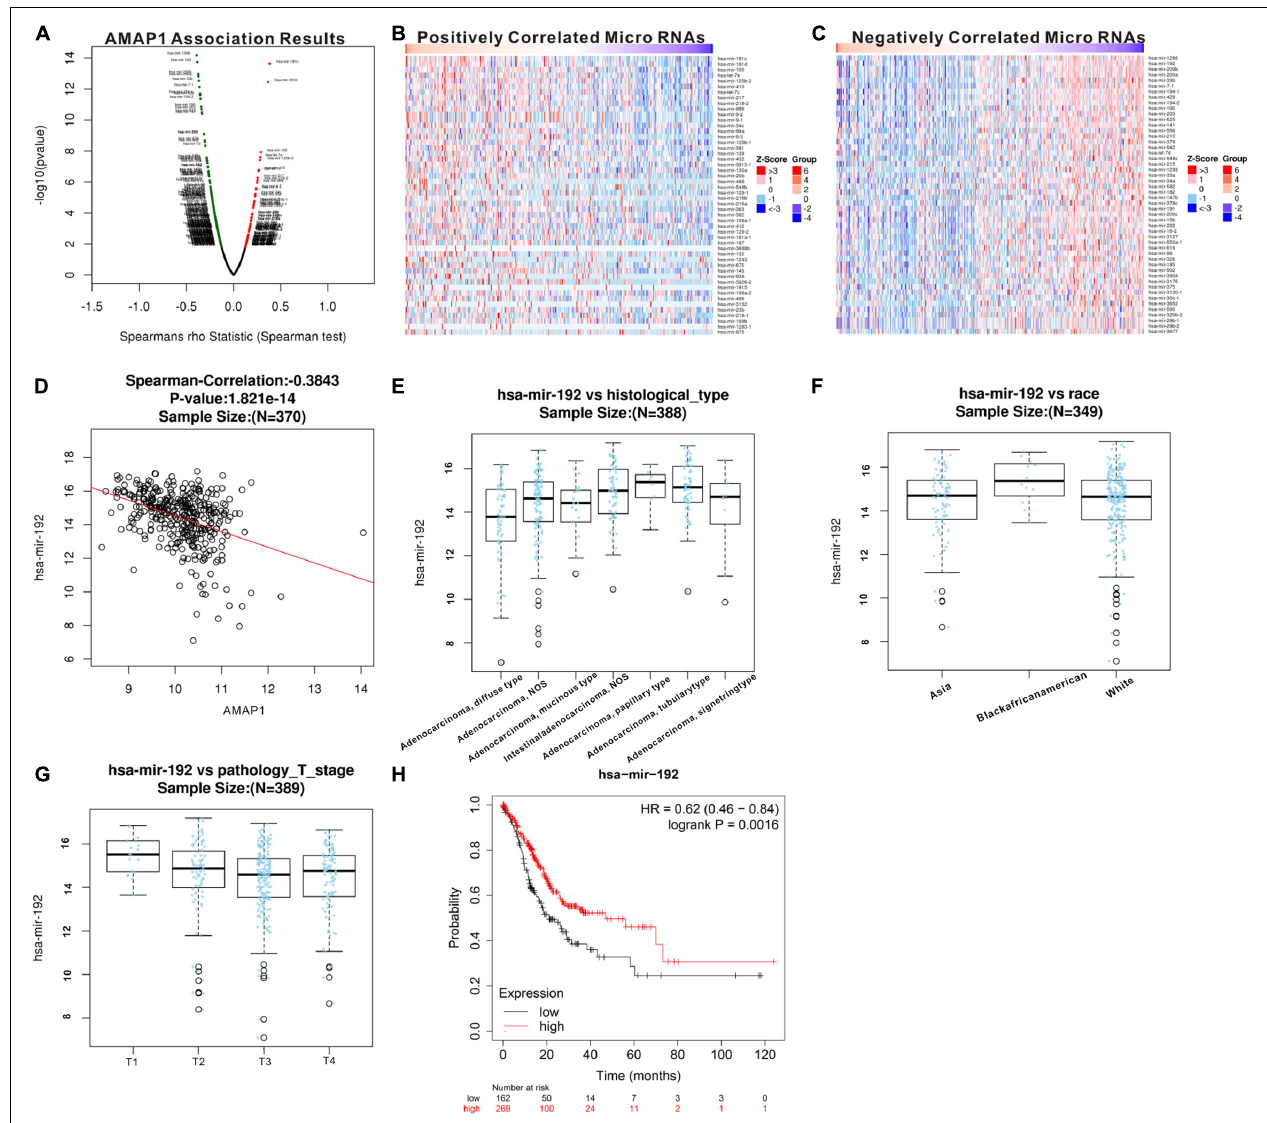
FIGURE 6 | Identification of MicroRNAs associated with AMAP1mRNA expression in 415 gastric cancer samples from the linkedomics database. Volcano plot of MicroRNAs significantly associated with AMAP1mRNA (A) . The top 50 MicroRNAs positively correlated to the expression of AMAP1mRNA (B) . The top 50 MicroRNAs negatively correlated to the expression of AMAP1mRNA (C) . Scatter plot of the association between AMAP1mRNA expression and has-mir-192 (D) . Expression of hsa-miR-192 is associated with histological type (E) , race (F) , and T stage (G) . High levels of has-mir-192 predict favorable overall survival in gastric cancer patients (H)